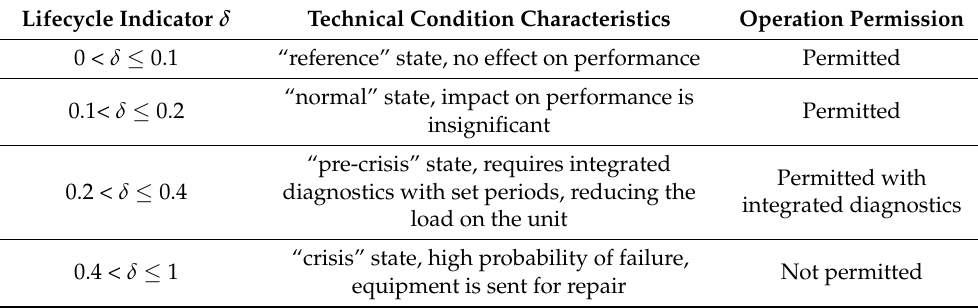
Table 3. Assessment levels of AM